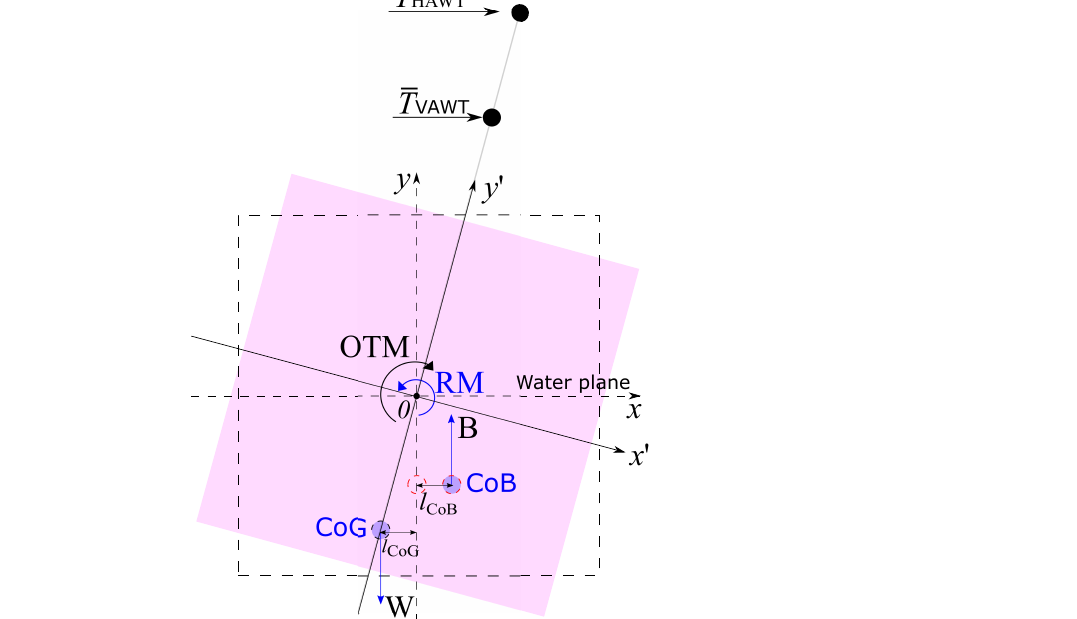
Figure 8. Schematic of a free floating wind platform, with the overturning moment (OTM), due to average thrust force ( ˆ T ), and the restoring moment (RM), due to buoyancy and gravity forces acting at the centre of buoyancy (CoB) and gravity (CoG),